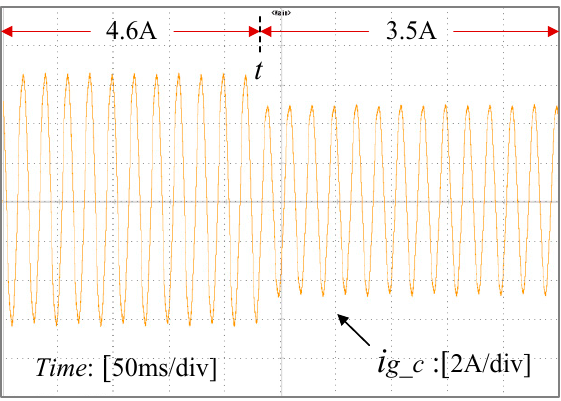
Figure 22. Experimental results of the dynamic response with i ref mutation.